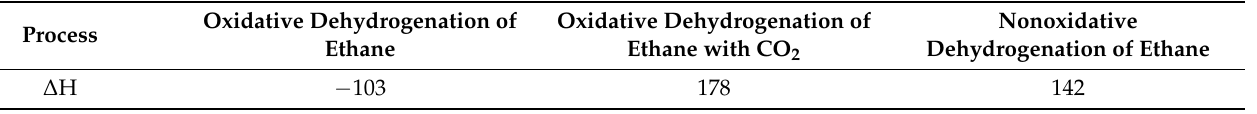
Table 1. Reaction enthalpy of ethylene production by different processes at 600 ( ◦ C), kJ/mol. Oxidative Dehydrogenation of Oxidative Dehydrogenation of Nonoxidative Process Ethane Ethane with CO 2 Dehydrogenation of Ethane ∆ H − 103 178